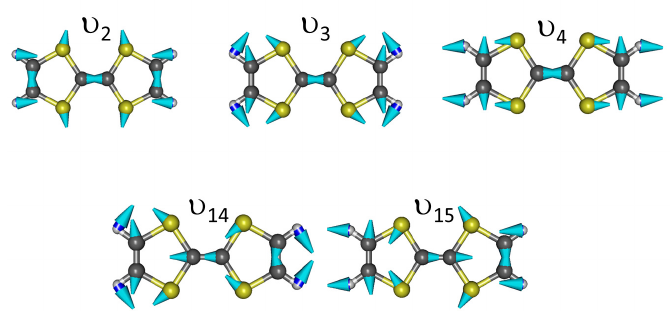
Figure 9. In the upper row, the gerade a g modes ν 2 , ν 3 , and ν 4 of TTF are depicted. The ungerade b 1 u mode ν 14 and ν 15 are displayed in the second